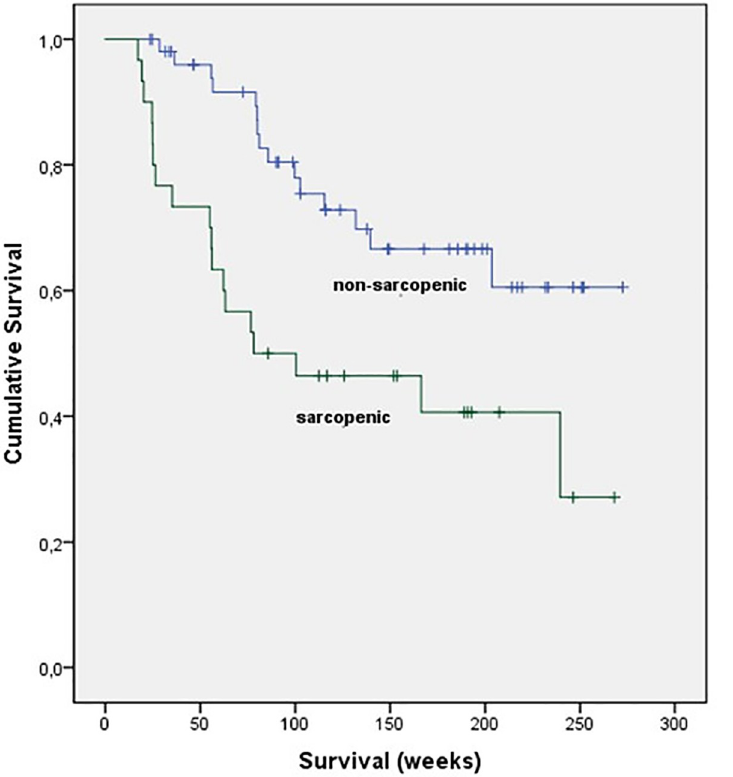
Fig 2. Survival; sarcopenic vs. non-sarcopenic patients; Kaplan-Meier-analysis.